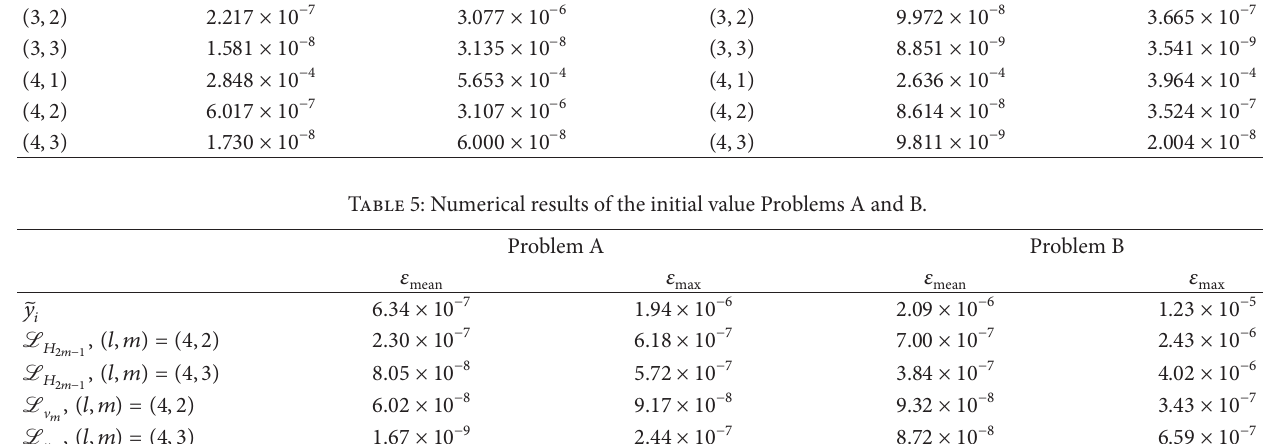
Table 4: Numerical results of the operators L 𝐻